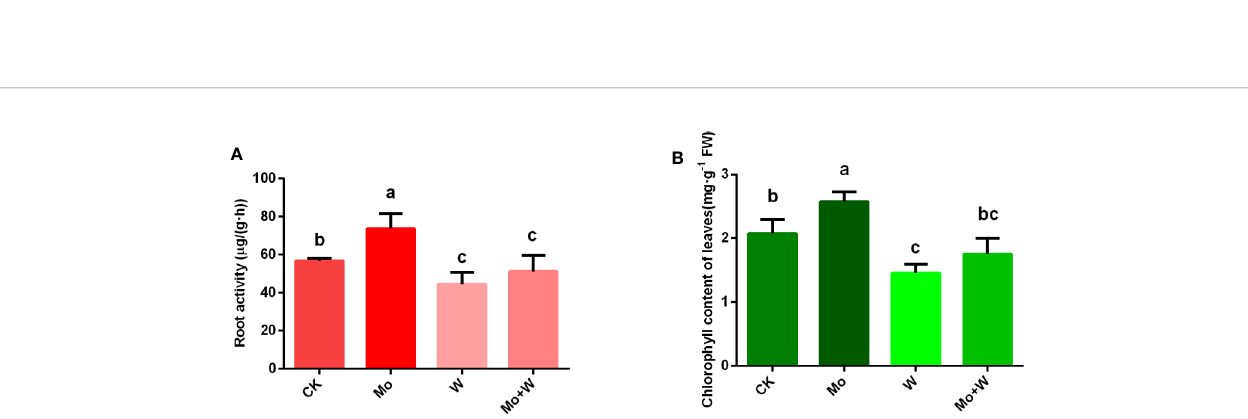
FIGURE 2 | Effect of solid MS culture medium with Na 2 MoO 4 or Na 2 WO 4 on root activity (A) and chlorophyll content of leaves (B) . Values are means±SD. Different letter denote statistical signi fi cance according to one-way ANOVA and Duncan ’ s test (P <0.05).